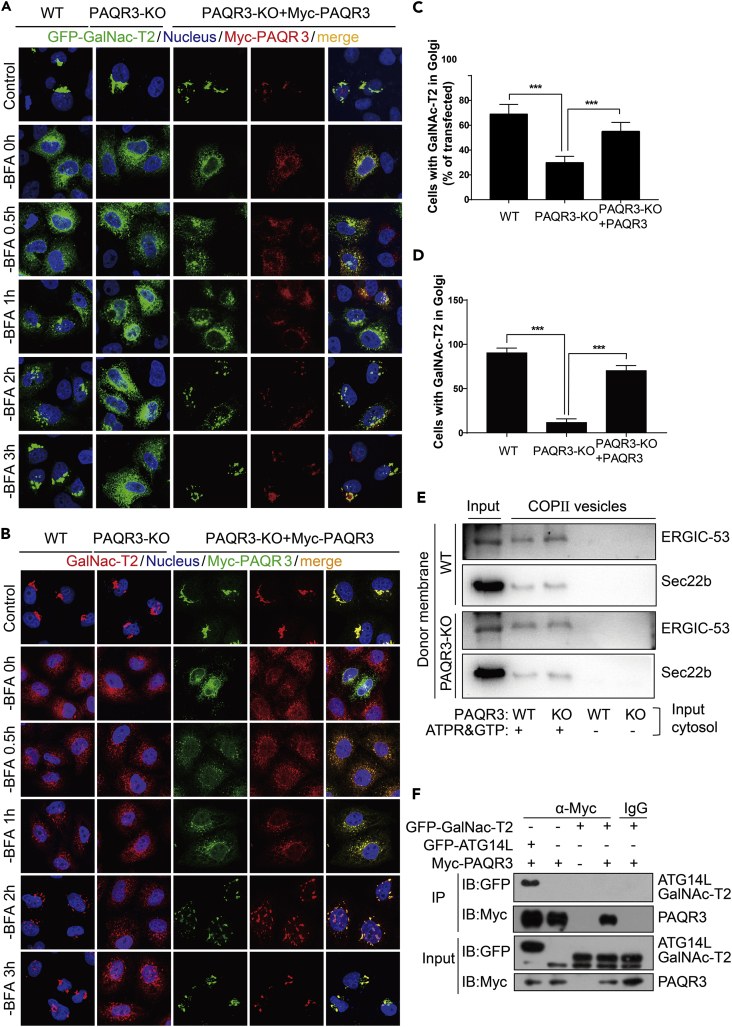
Deletion of PAQR3 Delays ER-to-Golgi Trafficking of GalNac-T2(A and B) ER-to-Golgi transport of exogenous and endogenous GalNAc-T2 in HeLa cells. HeLa cells without or with PAQR3 deletion (WT or PAQR3-KO) were transiently transfected with GFP-GalNAc-T2 and Myc-tagged PAQR3 as indicated. At 24 hr after the transfection, the cells were treated with 5 μg/mL BFA for 30 min. The cells were then analyzed by fluorescence microscopy at different times after BFA removal. Endogenous GalNac-T2 was analyzed by an antibody against GalNAc-T2. The nucleus was stained with Hoechst 33342. All of the images were taken with the same exposure.(C and D) Quantitation of results of A and B. The quantitation of cells with GFP-fused GalNAc-T2 in the Golgi at 3 hr after BFA removal is shown in C. Quantitation of Golgi-localized endogenous GalNAc-T2 at 3 hr after BFA removal is shown in D. At least 500 cells were counted for the quantitation. The data are shown as mean ± SD, *** for p < 0.001.(E) Analysis of COPII vesicle budding in vitro. COPII-budding reactions using cytosolic fractions from WT or PAQR3-KO MEFs and membrane fractions (memb) from WT or PAQR3-KO MEFs. LMAN1/ERGIC-53 and Sec22b are COPII cargos, whose incorporation into budded vesicles needs energy supplied by ATP regeneration system (ATPR) and GTP. The experiment was repeated three times with similar results.(F) Analysis of interaction between PAQR3 and GalNAc-T2. Myc-tagged PAQR3, GFP-fused GalNAc-T2, and GFP-fused ATG14L were transiently expressed in HEK293T cells as indicated. After transfection for 24 hr, the cell lysate was used in immunoprecipitation (IP) and immunoblotting (IB) with the antibodies as indicated. ATG14L was used as a positive control (Xu et al., 2016). The experiment was repeated three times.